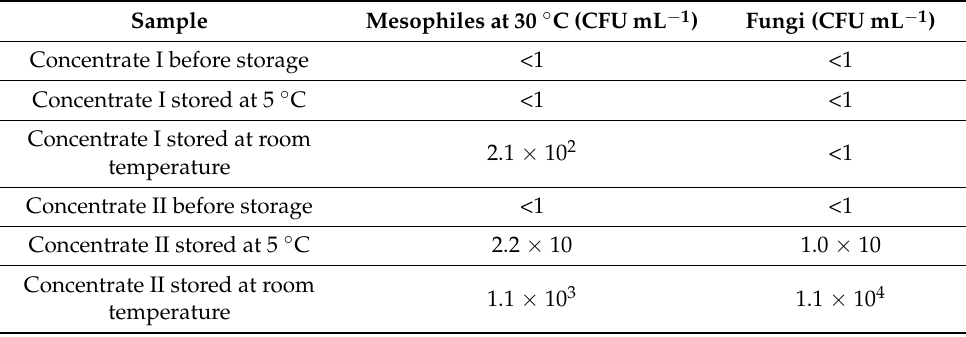
Table 3. Results of microbial counting obtained for concentrates before storage and after five months of storage. Sample Mesophiles at 30 ◦ C (CFU mL − 1 ) Fungi (CFU mL − 1 ) Concentrate I before storage <1 <1 Concentrate I stored at 5 ◦ C <1 <1 Concentrate I stored at room 2.1 × 10 2 <1 temperature Concentrate II before storage <1 <1 Concentrate II stored at 5 ◦ C 2.2 × 10 1.0 × 10 Concentrate II stored at room